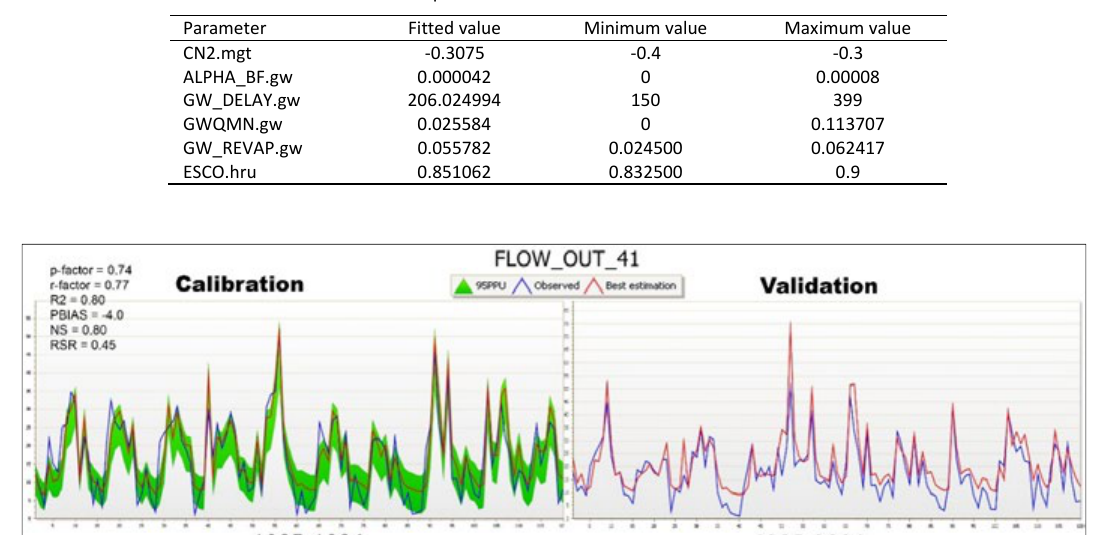
Table 3. SWAT model parameters used to calibrate the Muleta watershed